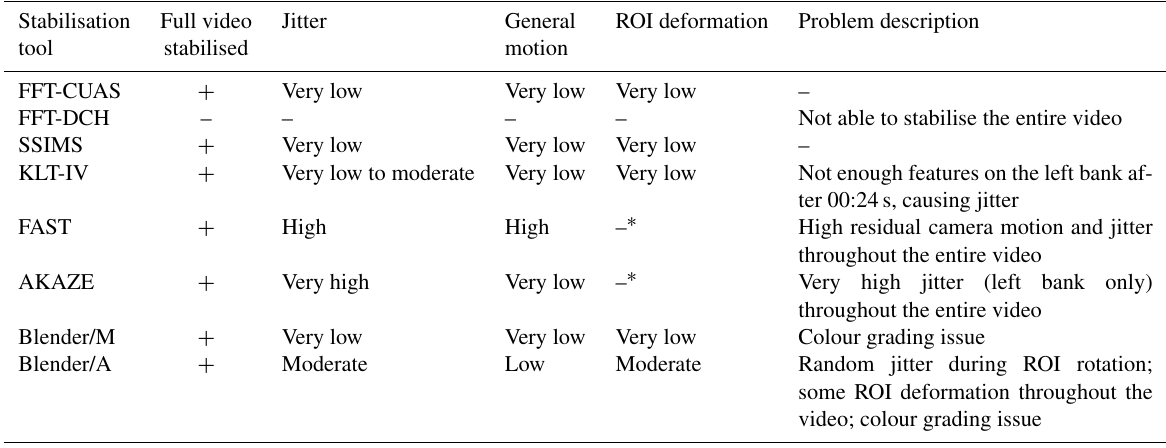
Table 5. Qualitative comparison of stabilisation results for case study 3 – Basento river.